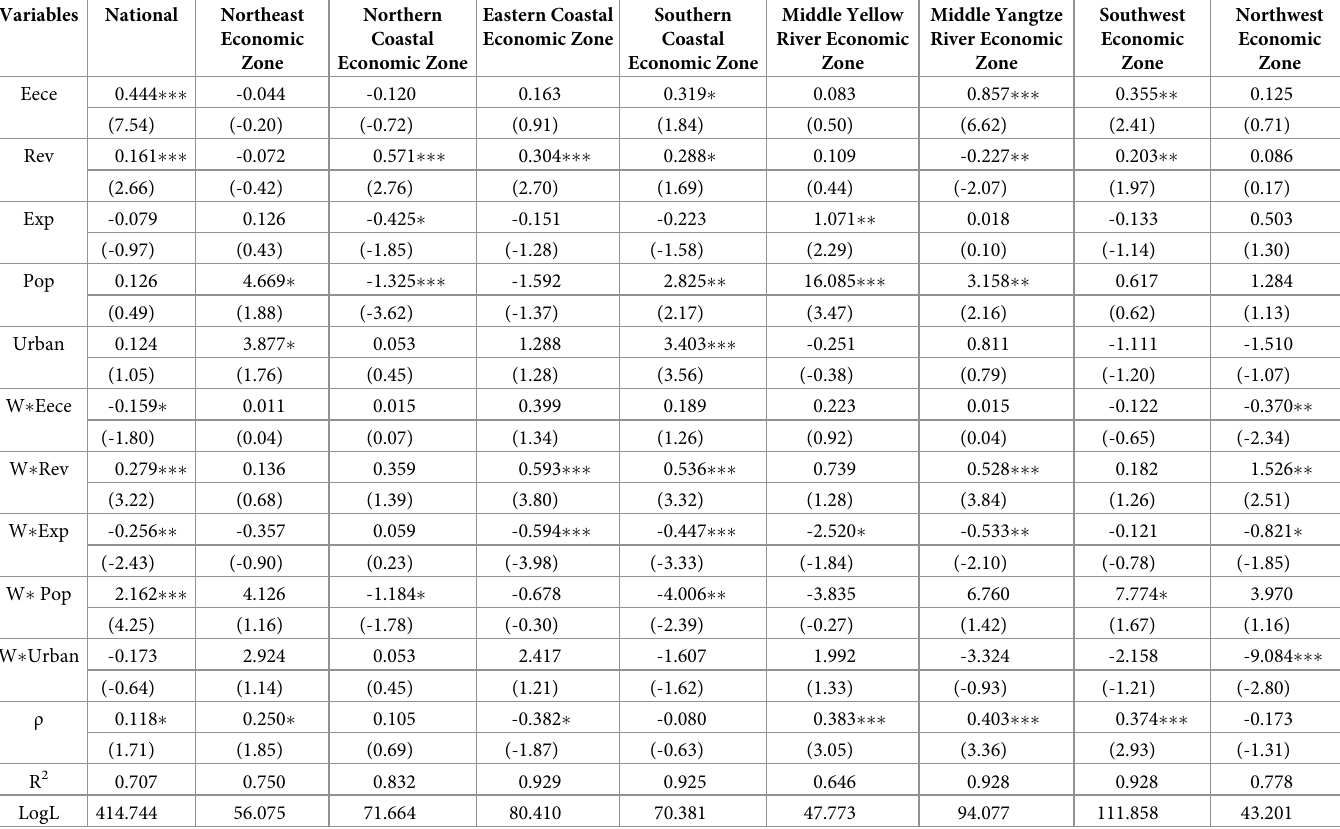
Table 7. Conditional β convergence of the coupling coordination of the energy-economy-carbon emission